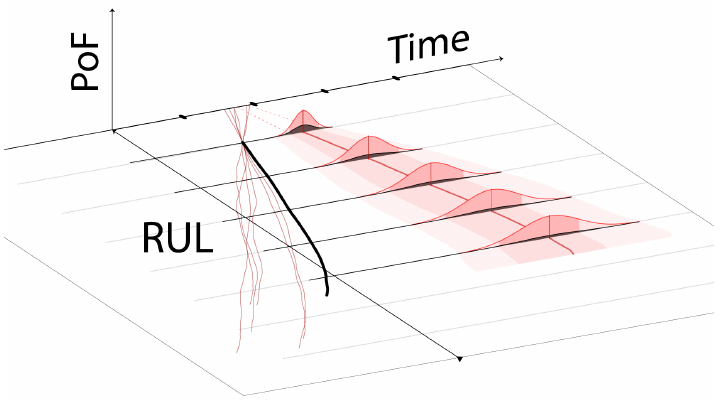
Figure 11. Sketch representation of the RUL trajectories and the PDF curves in 3D. The black line shows the current trajectory and the red lines are other past trajectories of the same component, all in Flight Hours. Here we can see that the red area, mentioned previously, is formed by successive PDF curves. In this figure, the PDF curves represented result from the trajectory comparison, and not from the model, as these were single value RUL prognostics. As such there are two red areas, the darker area shows the observed interval and the lighter one marks the 95% confidence interval, that is 2 standard deviations away from the